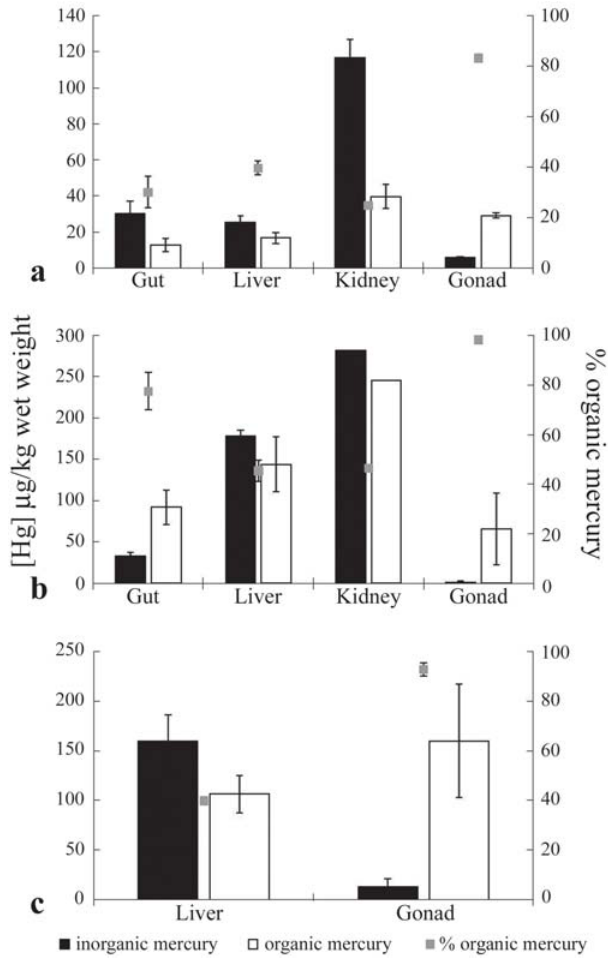
Fig. 3. Mean concentrations and ratios of mercury in different tissues of omnivorous (a), carnivorous (b), and detritivorous fishes (c) collected from Vigário Reservoir. Error bars represent one standard deviation of the